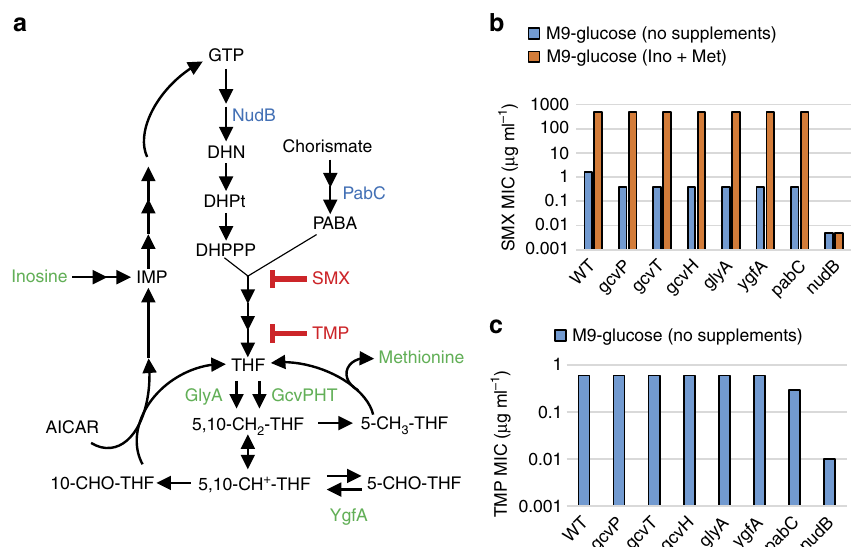
Fig. 2 Folate de fi ciency potentiates SMX activity. a Schematic of E . coli folate metabolism. Green characters indicate metabolites and enzymes that affect SMX susceptibility. Blue characters indicate enzymes that affect both SMX and TMP susceptibility. b MICs of SMX and TMP for E . coli folate pathway mutants were determined after 24 h of incubation at 37 °C in M9-glucose medium. The selected E . coli single-gene deletion mutants and their parental strain BW25113 (WT) from the Keio collection 8 were used. c Effects of inosine (Ino) and methionine (Met) on SMX MIC against E . coli BW25113. Ino and Met were added to the medium at 10 µ g ml − 1 . MICs of SMX were determined after 24 h incubation at 37 °C in M9-glucose medium. Representative data from at least three independent experiments are